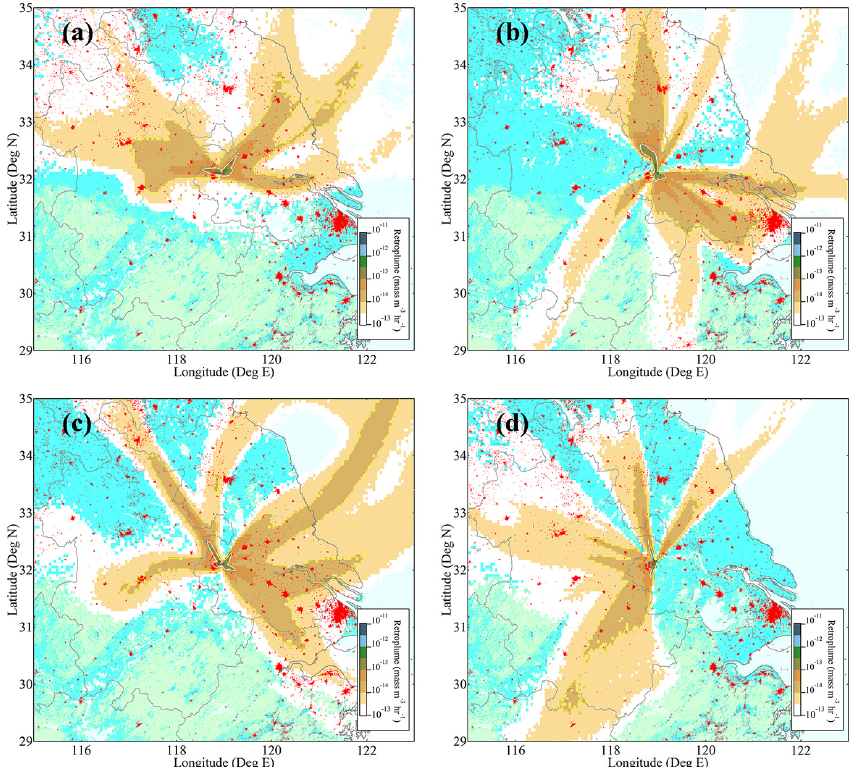
Figure 11. The averaged retroplumes (i.e., 100m footprint) of the selected events: (a) high J 6 , (b) low J 6 , (c) high GR, (d) low GR days (the dates are marked in Fig. 8c and d.). Note: the red areas in the maps show the locations and sizes of the